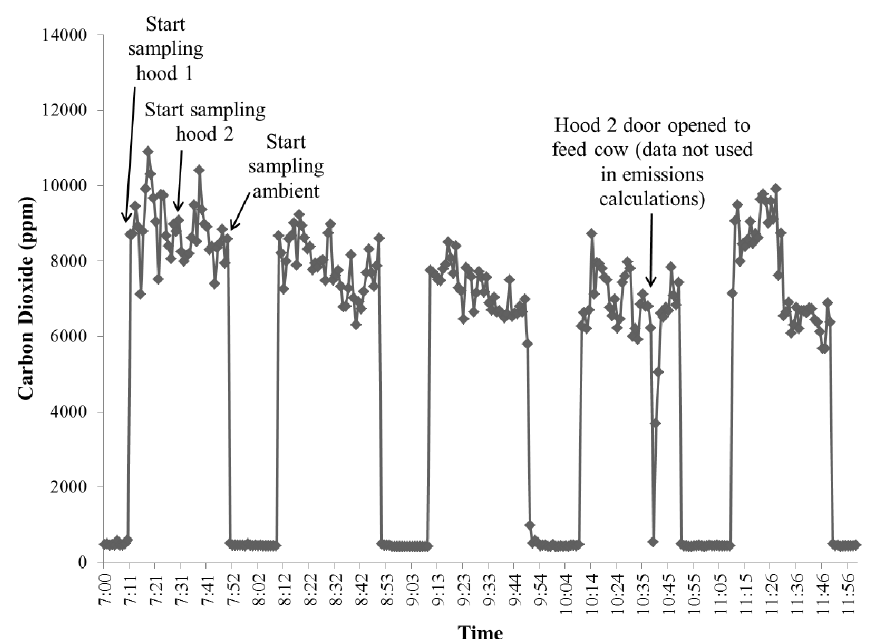
Figure 9. Example of raw carbon dioxide concentrations (ppm) over time from the INNOVA